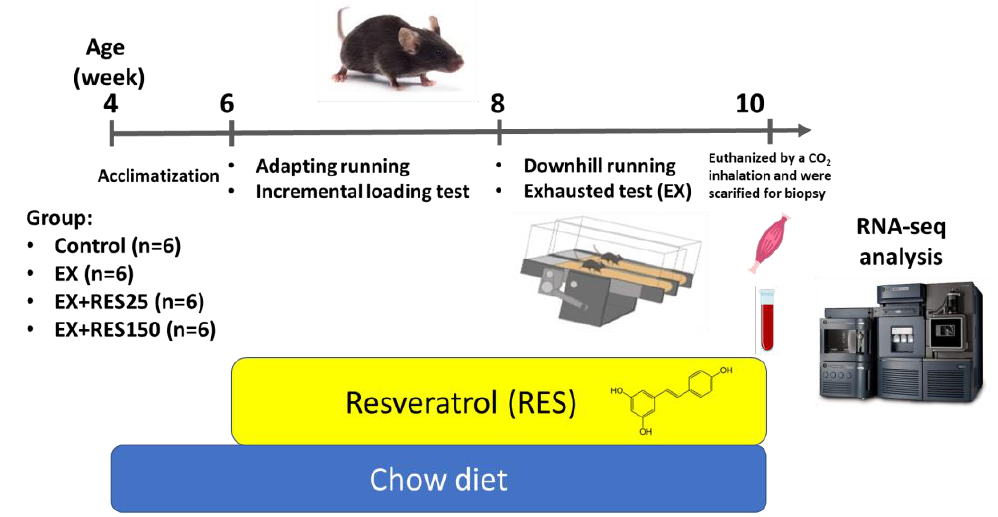
Figure 1. Experimental design of short-term downhill training. NC: control ( n = 6); EX: exercise ( n = 6); EX + RES25: exercise with resveratrol 25 mg/kg ( n = 6); EX + RES150: exercise with resveratrol 150 mg/kg ( n = 6).